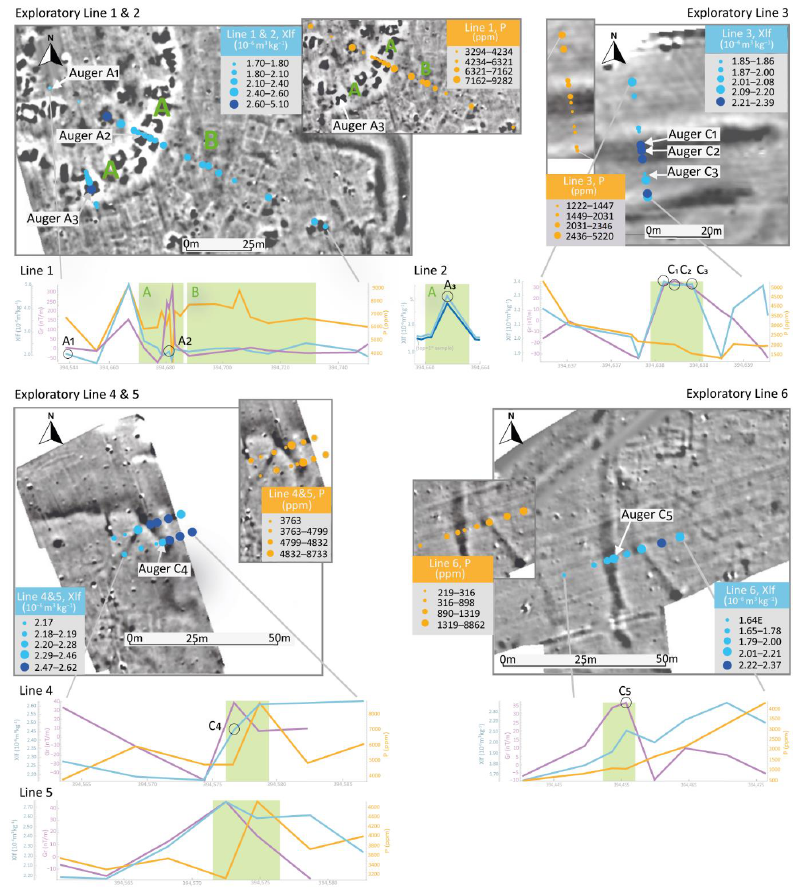
Figure 7. Bubble plots (overlying the magnetometer survey results) showing the lateral low-frequency magnetic susceptibility (χlf, in blue) and phosphate (P, in orange) distribution along the exploratory lines at Almyriotiki. The grayscale image shows positive magnetic anomalies in black and negative anomalies in white. The grayscale image is shown at 70% opacity in Figures 1 and 2 to facilitate visualization of the bubble plots. The x –y graphs also show the lateral variation of the χlf (blue line) and P (orange line), including the magnetic-gradient intensity (Gr, purple line). In the graphs, the location of the targeted features is indicated in green (the labels A and B indicate the two areas in Lines 1 and 2). The location of the in-depth augered points is indicated as a reference for Figure 8, where the in-depth results are shown. The location of the lines is shown in Figure 2. Auger A1 had averaged χlf values of 2.1 × 10 −6 m 3 /kg up to ~0.33 m in depth, followed by a general decrease of values (Figure 8). Auger A2, targeting the area with strong mag- netic responses, resulted in averaged lower χlf values (2.4 × 10 −6 m 3 /kg up to ~0.33 m